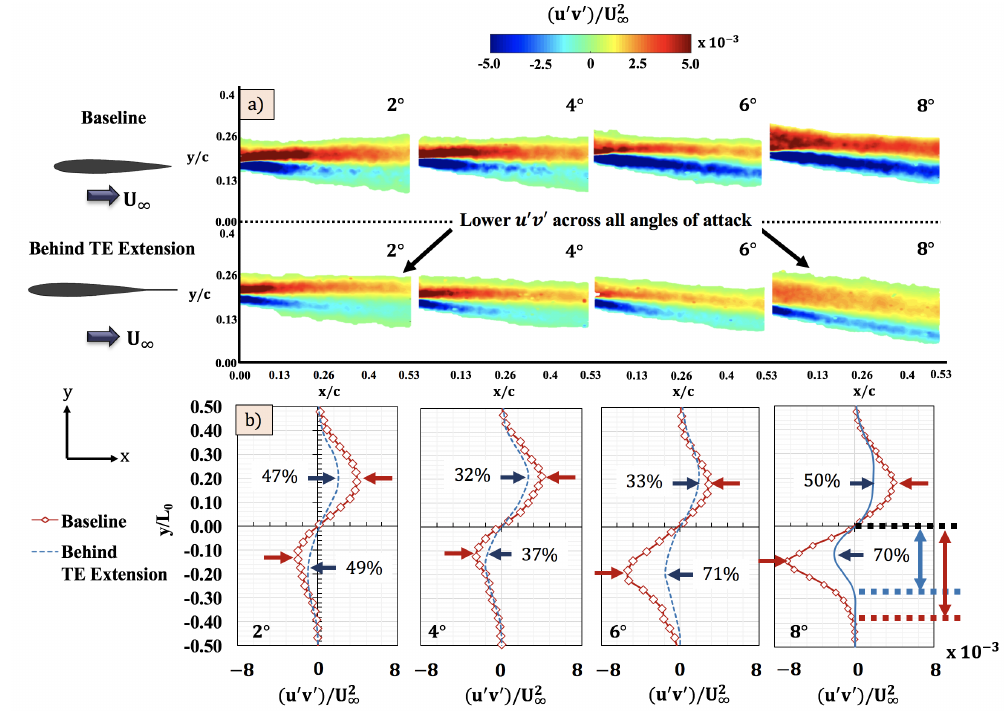
Figure 18. ( a ) Streamwise Reynolds stress contours in FSL behind the trailing edge of the NACA 0012 wing and behind the TE extension ( b ) Reynolds stress profiles at different angles of attack for both cases. The Reynolds stress behind the TE extension is lower across all angles of attack when compared to the